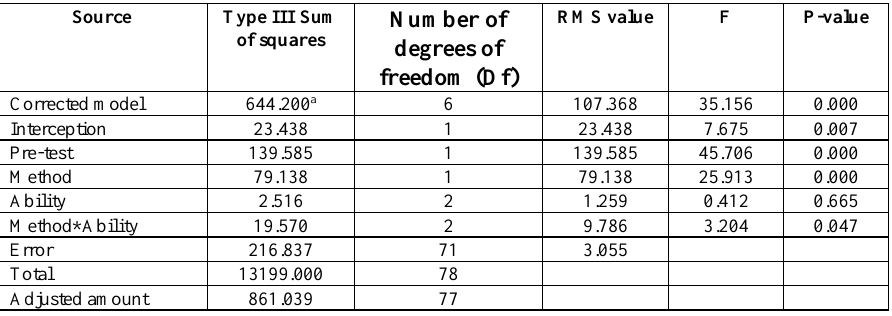
Table 3. Testing the Impact of Ability Factors and Learning Methods on Academic